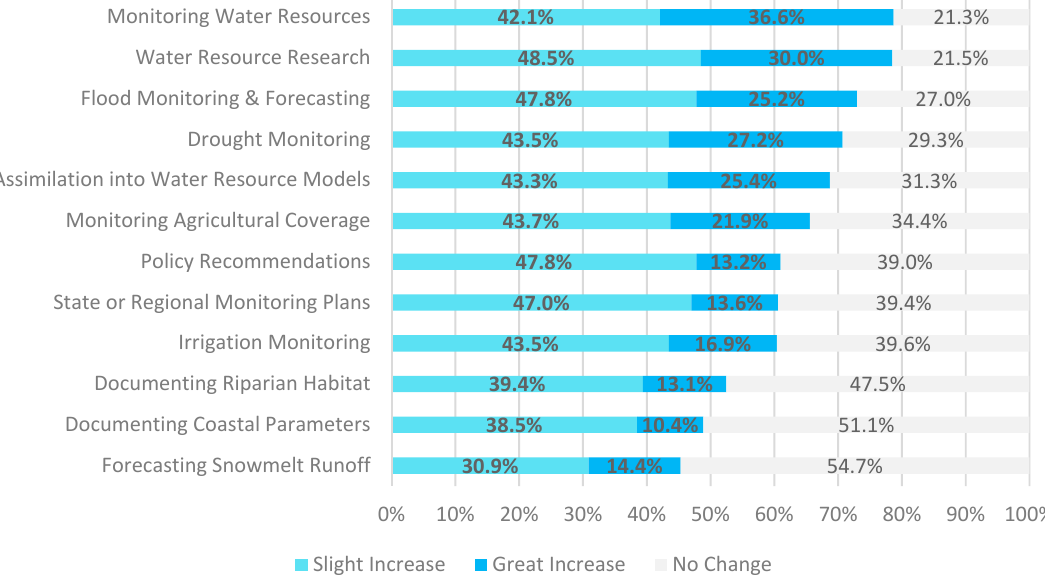
Figure 10. Change in use of RSD as a result of ARSET for water resource research and management. Light blue = slight increase; dark blue = great increase; gray = participants for whom the task was applicable, but who indicated no change in their use of RSD for that task ( N = 192 − 235, with 0–35 claiming the task was not applicable).